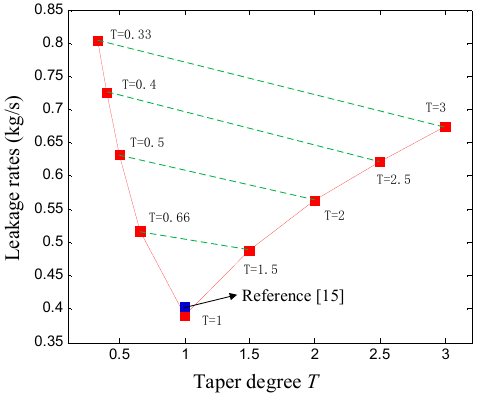
Figure 7. Influence of taper degrees T on the leakage rate.